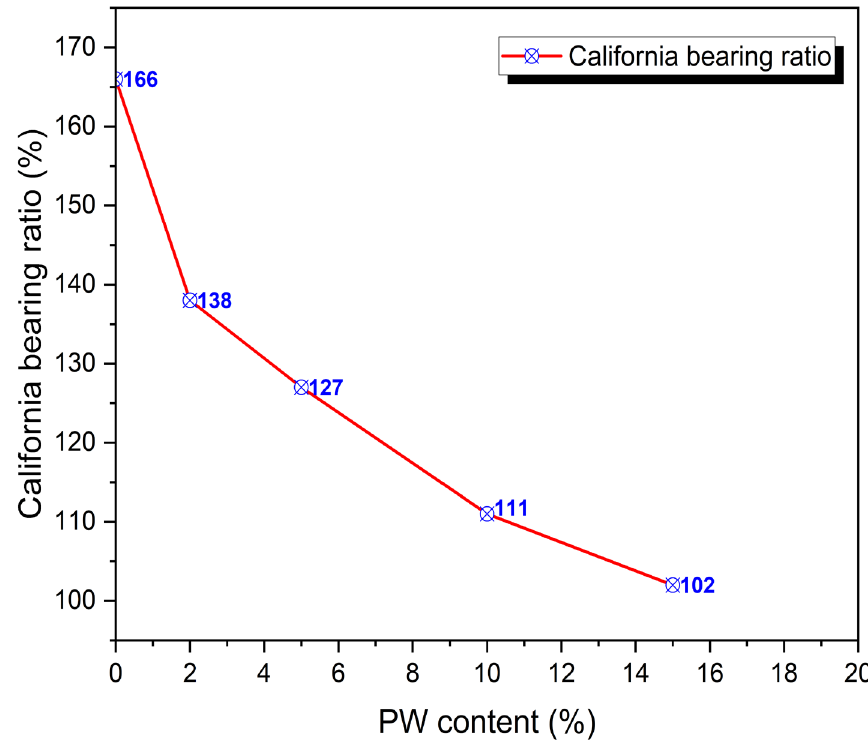
Figure 6. Variation of CBR for cement-stabilised soil with PW content .